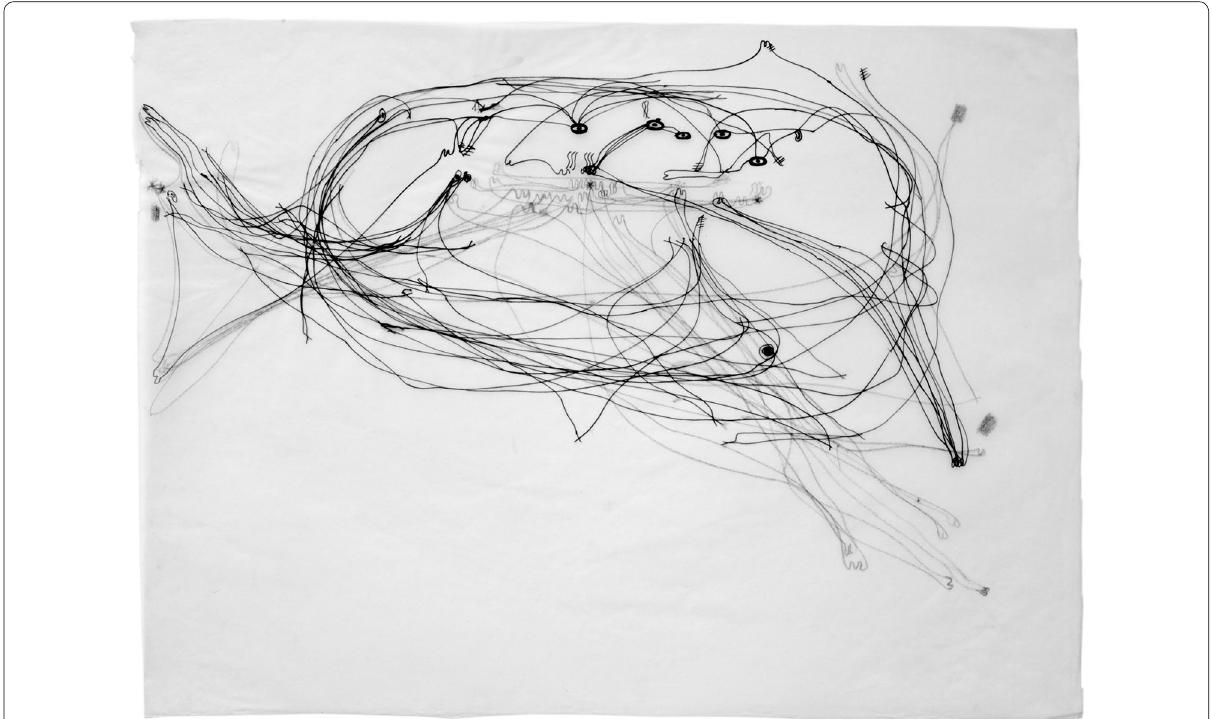
Fig. 1 Fernand Deligny, Lignes d’erre [Wander Lines] . Courtesy Maison d’édition l’Arachnéen,